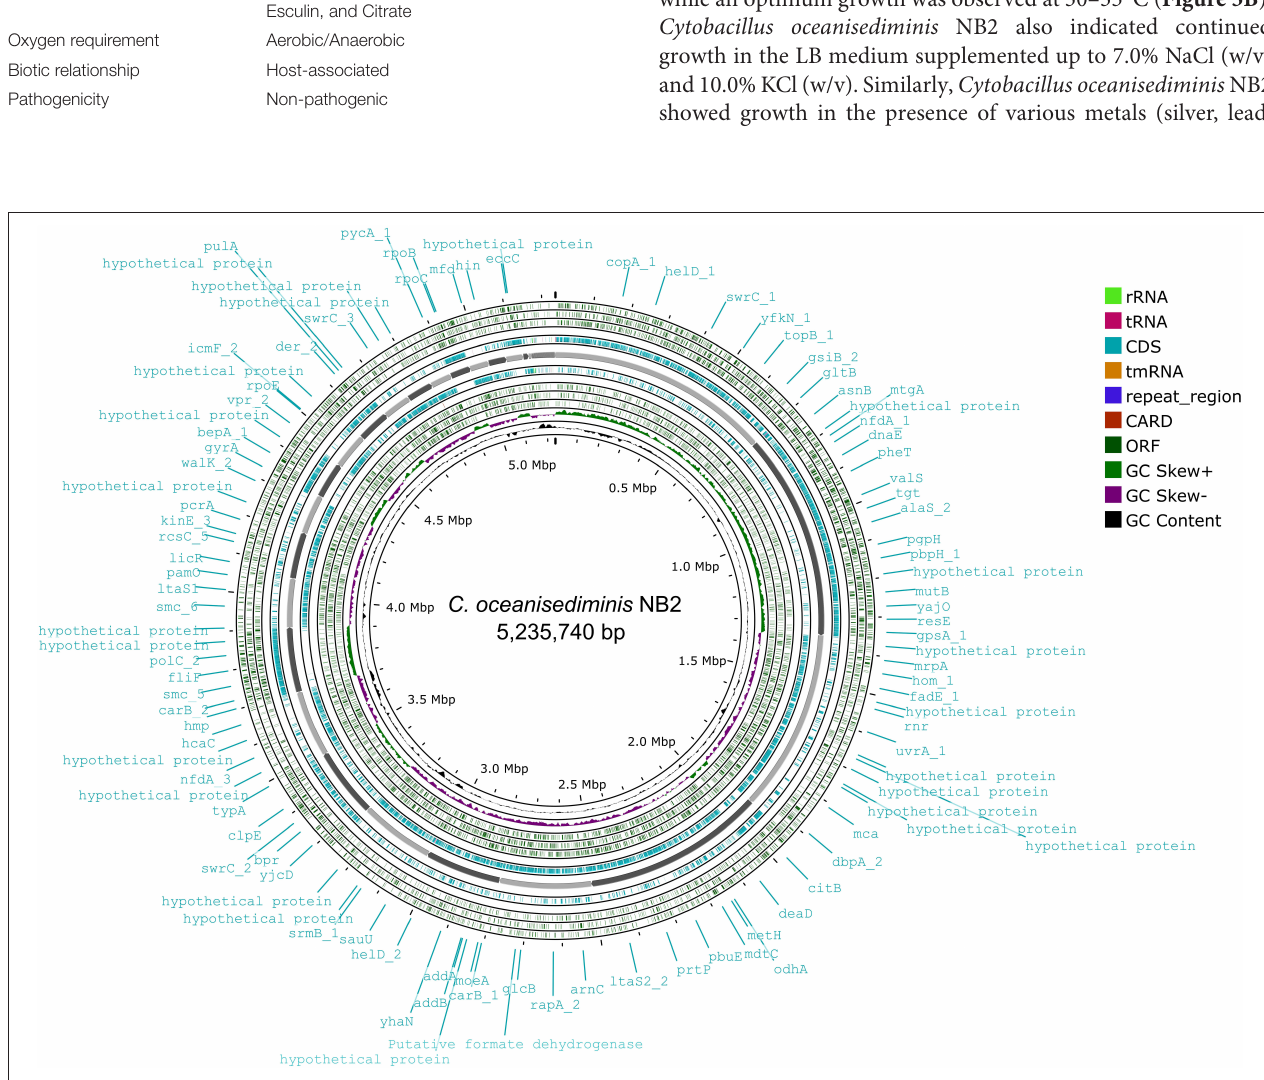
FIGURE 3 | Genome map of the Cytobacillus oceanisediminis NB2. The circular genome map was drawn using Proksee online tool (https://proksee.ca/) that uses a complete genome sequence and annotates it using PROKKA. It also identifies resistance gene using CARD identifier.